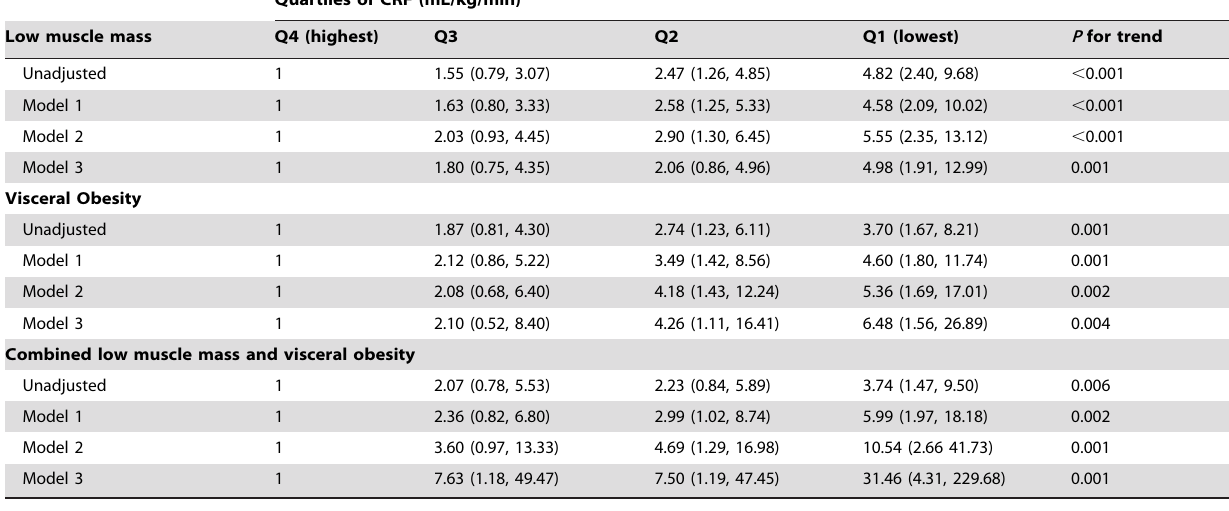
Table 4. Unadjusted and adjusted odds ratios (ORs) with 95% confidence intervals (CIs) of having low muscle mass only, visceral obesity only and combined low muscle mass and visceral obesity by quartiles of CRF (mL/kg/min) adjusting for potential compounding